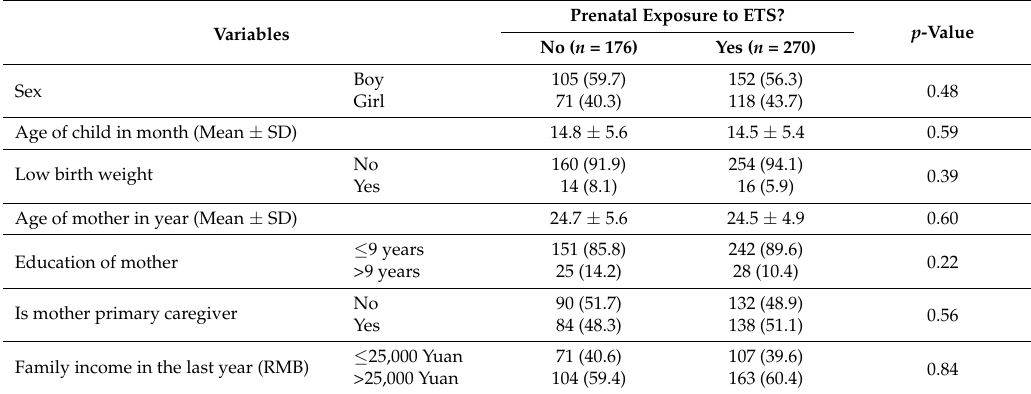
Table 1. Comparison of socioeconomic characteristics between children with and without maternal prenatal exposure to ETS (environmental tobacco